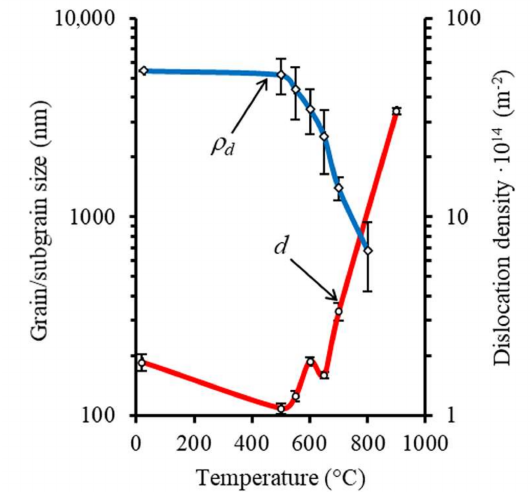
Figure 8. Effect of annealing temperature on the transversal grain/subgrain size (d) and the disloca- tion density ( ρ d ). The error bars on the plots denoted the confidence interval with the significance level of